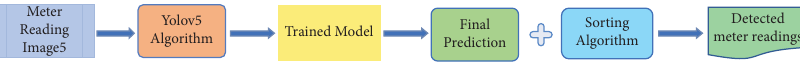
Figure 7: Developed novel ofine OCR approach fow.